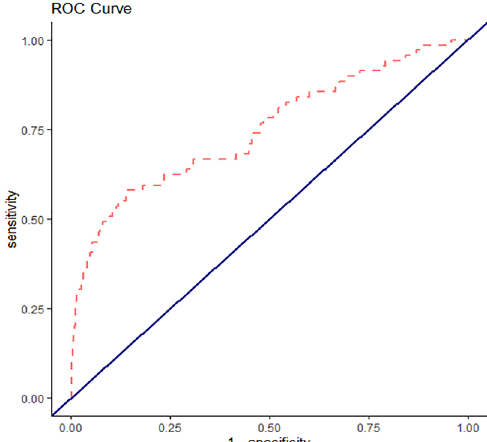
Figure 2. Receiver operating characteristic curve for seven-day mortality with individual